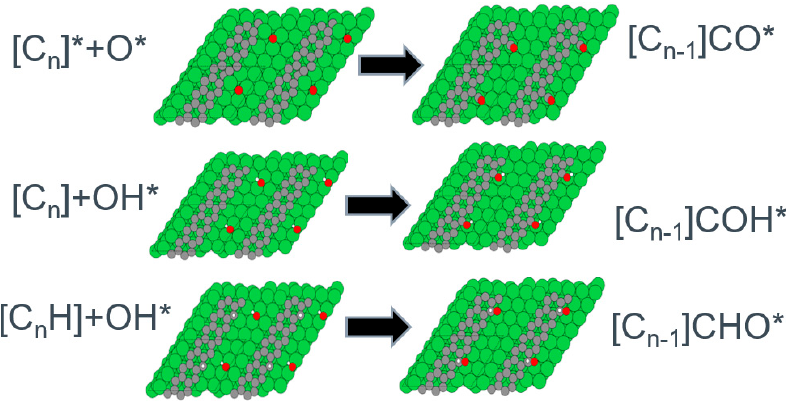
Figure 11. Ball and stick model of the reactants and products in the reactive burn-off of polymeric carbon by direct carbon monoxide, hydroxyl, and formyl formation routes.